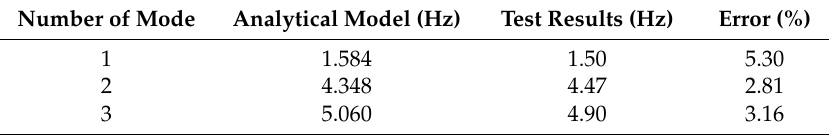
Table 1. Experimental and Analytical Natural Frequencies.